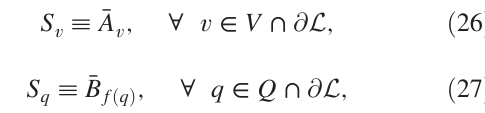
FIG. 5. Symmetry operators on the boundary (a) S q ∈ ∂ L , (b) S with v ∈ ∂ L . Thick lines denote neighbor v relations, and dashed lines denote the cubic